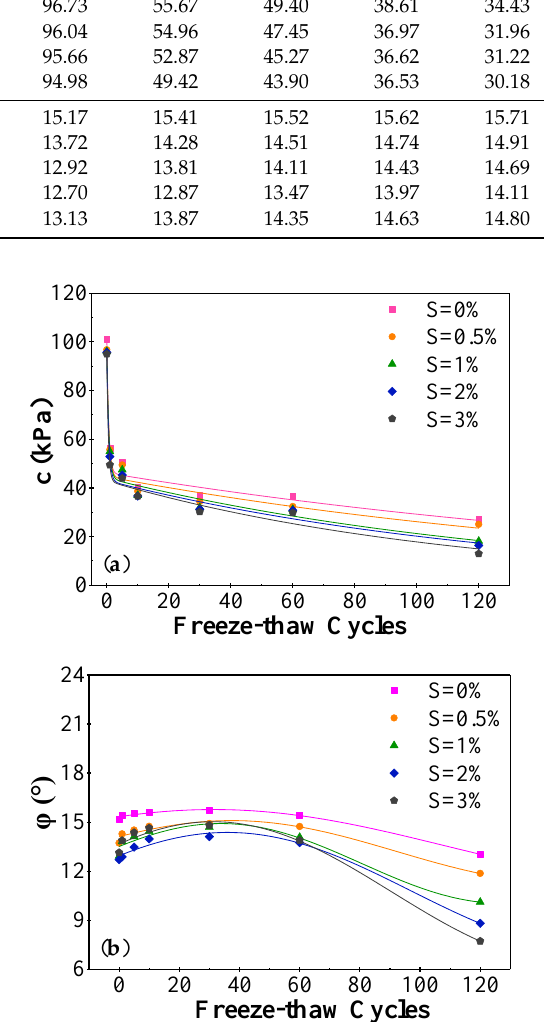
Figure 3. Variation of shear-strength parameters with FTC: ( a ) cohesion c; ( b ) internal friction angle ϕ